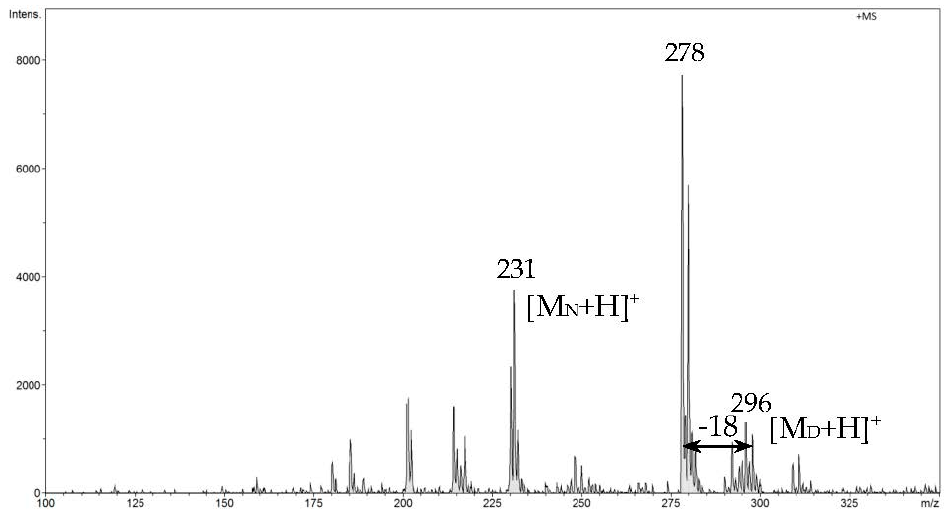
Figure 12. FAPA-MS spectrum recorded in the last heating phase from 160 ◦ C to 300 ◦ C. Figure 12. FAPA ‐ MS spectrum recorded in the last heating phase from 160 °C to 300 °C. To validate the method described in the experimental section, the FAPA-MS analytical technique, the molecularly imprinted polymer from the AFFINILUTE TM MIP-NSAIDs columns, and drug solutions with concentrations of 0.5–1.50 µ g (Table 4) were used. Table 4. Analytical parameters for FAPA-MS in the analysis of drug solutions using AFFINILUTE TM MIP-NSAIDs Table 4. Analytical parameters for FAPA ‐ MS in the analysis of drug solutions using AFFINILUTE TM MIP ‐ NSAIDs columns.